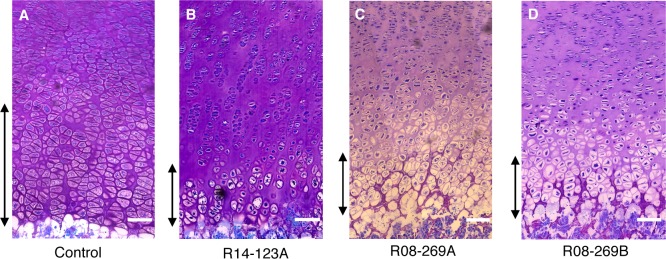
Pronounced disorganization of hypertrophic chondrocytes caused by SF3B4 mutations.Toluidine blue staining of the distal femur growth plate from (A) a control fetus, (B) R14-123A, (C) R08-269A and (D) R08-269B. The hypertrophic zone is marked with double arrows. Images were obtained at 20X magnification. Scale bars are 100 μM.